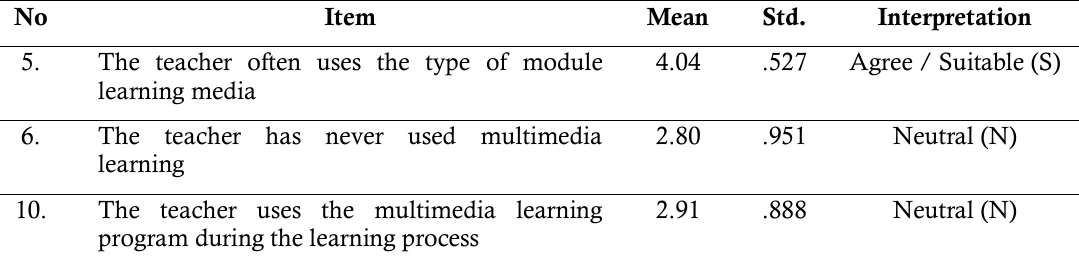
Table 3 . Student Responses to the Use of Instructional Media